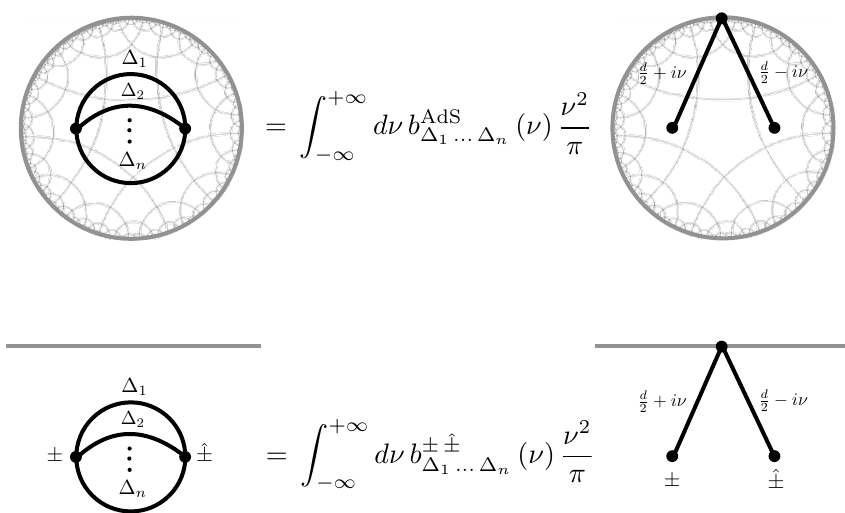
Figure 19. Products of bulk-to-bulk propagators at the same two bulk points admit a spectral decomposition, which is owing to the completeness and orthogonality of harmonic functions Ω AdS Owing to the relations between propagators in EAdS and dS, the spectral function b ± ˆ ± can be expressed in terms of the AdS spectral function b AdS